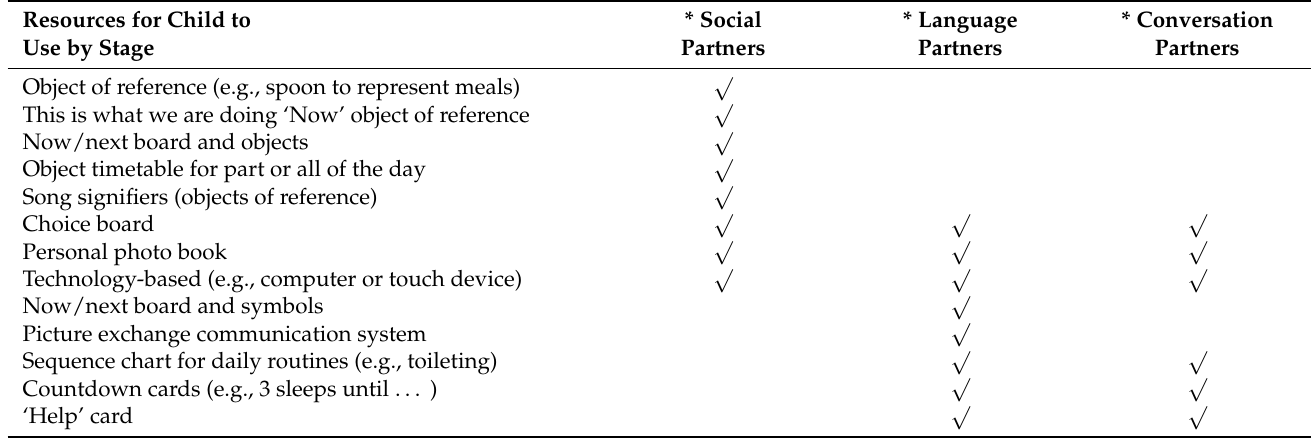
Table 1. Visual support resource bank available to staff delivering the